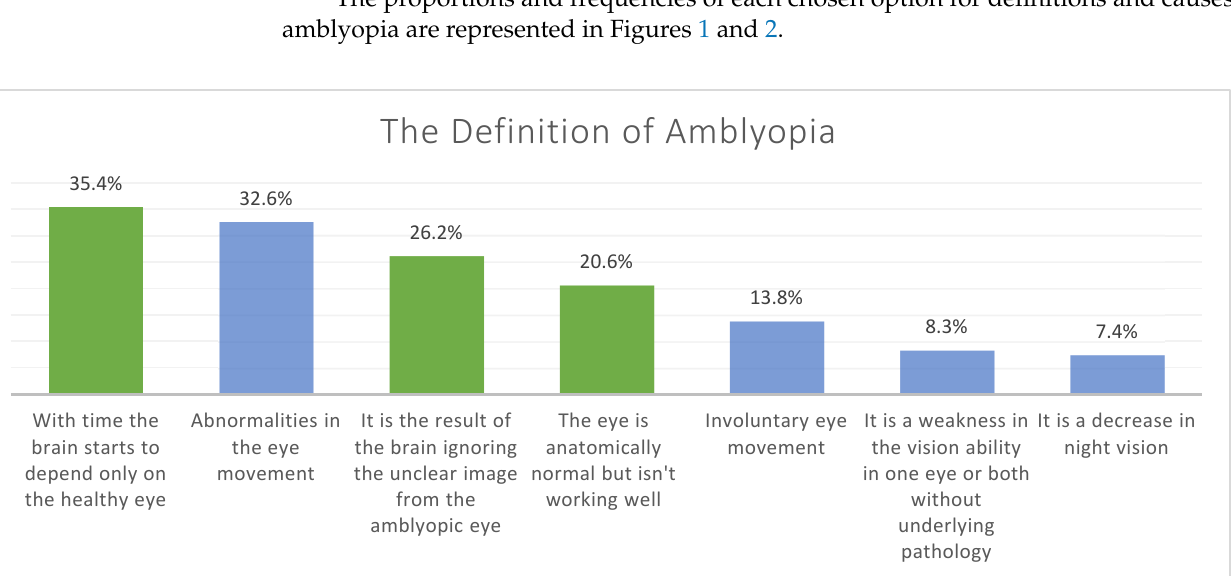
Figure 2. The proportions of participants’ responses for their knowledge regarding the causes of amblyopia, where they had the option to choose more than one answer. (The correct answers are represented by green bars and the incorrect answers by blue bars).